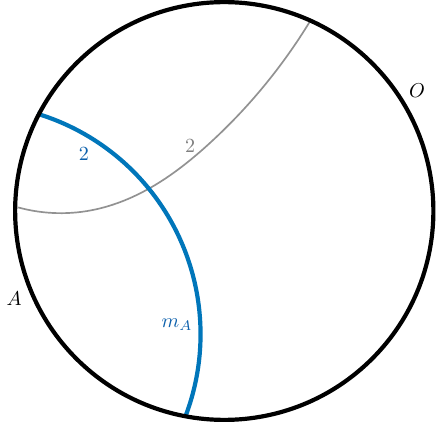
Figure 3 . The optimal barrier configuration ν ∗ of (2.9) consists of placing a barrier of two on the RT surface m . This is the smallest configuration possible such that every 2-thread from A to O A will cross a barrier of at least two. The constraint is equivalent to the homology condition of the RT formula.